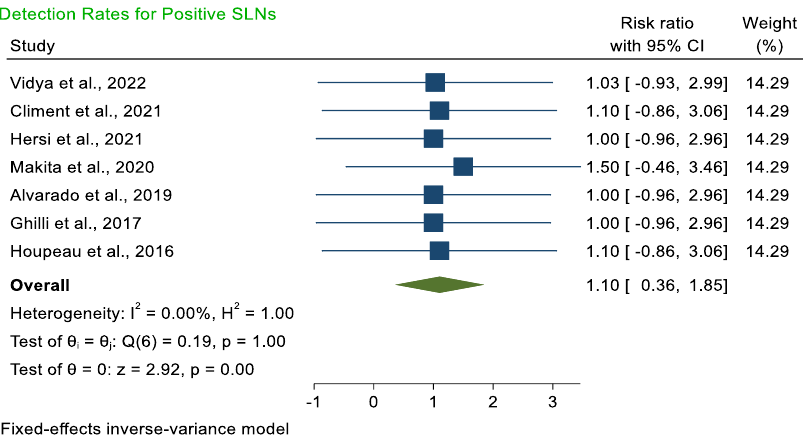
Fig. 5. The forest plot showed a positive sentinel lymph node detection